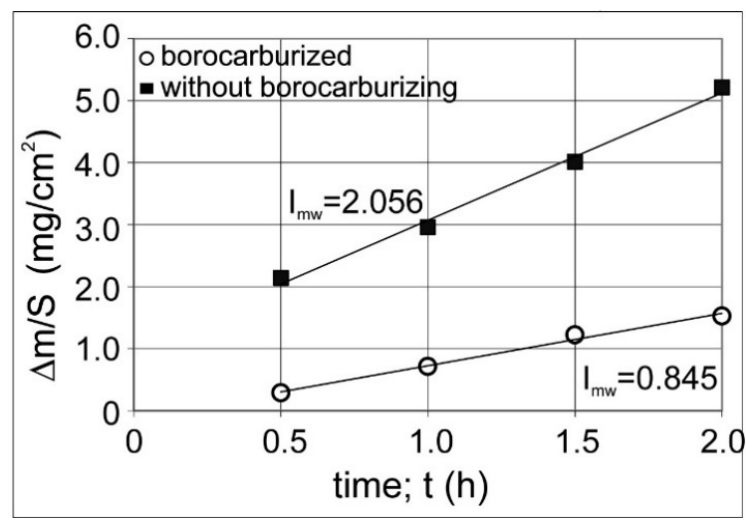
Figure 7. The results of wear resistance tests performed for gas borocarburized Armco iron in N 2 –H 2 – B(CH 3 O) 3 atmosphere at 1223 K (950 °C) for 2 h and untreated Armco iron (without borocarburizing).